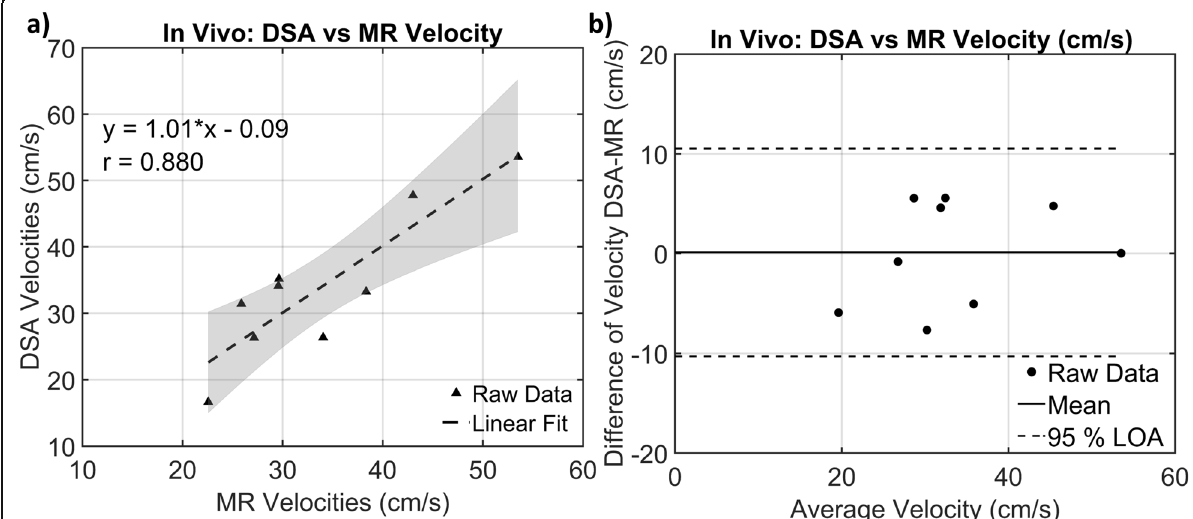
Fig. 5 a Linear regression analysis between the 4D Flow MRI velocities and the calculated qDSA velocities (r = 0.880, p = <.001). The shaded region represents the 95% confidence band. b Bland-Altman analysis between the 4D Flow MRI and qDSA velocities (Bias = 0.117 cm/s, LOA [ − 10.30 cm/s, 10.53